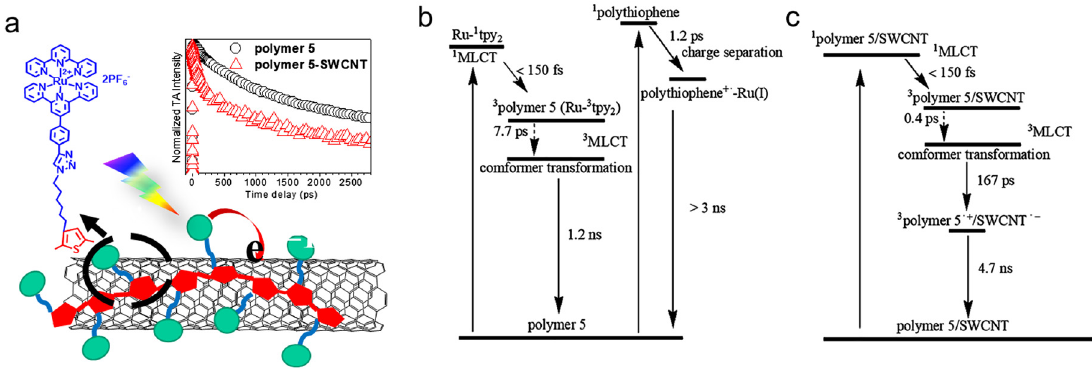
Figure 5: (a) Schematic illustration of the polymer 5/SWCNT hybrid, the decay kinetics at 680 nm achieved by fs-TA of both polymer 5 and the polymer5/SWCNThybrids is shownasinsetdiagrams; (b) Schematicdiagramshowingthephotophysical processesinpolymer5;(c) Thecharge injection process in the polymer 5/SWCNT hybrid (right) [41]. fs-TA, femtosecond transient absorption; SWCNT, single-wall